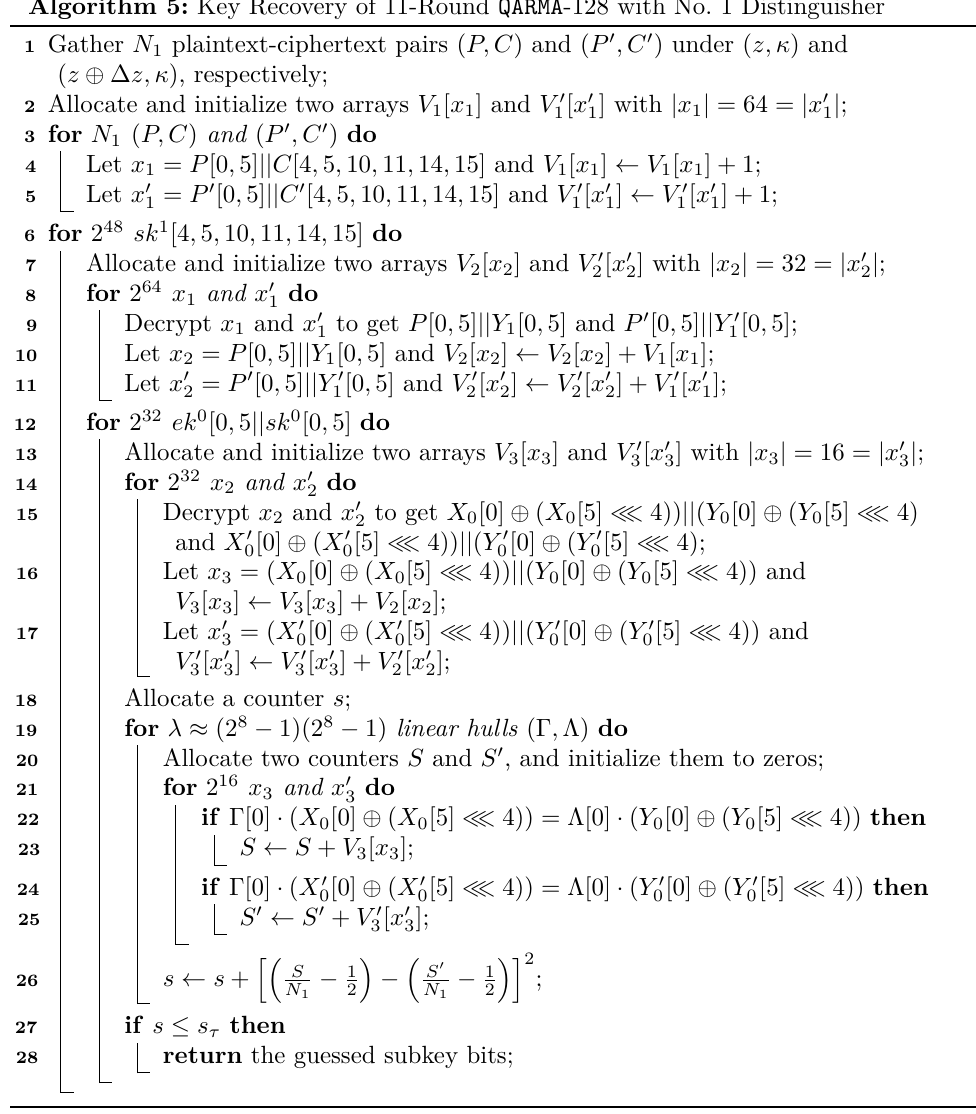
Algorithm 5: Key Recovery of 11-Round QARMA -128 with No. 1